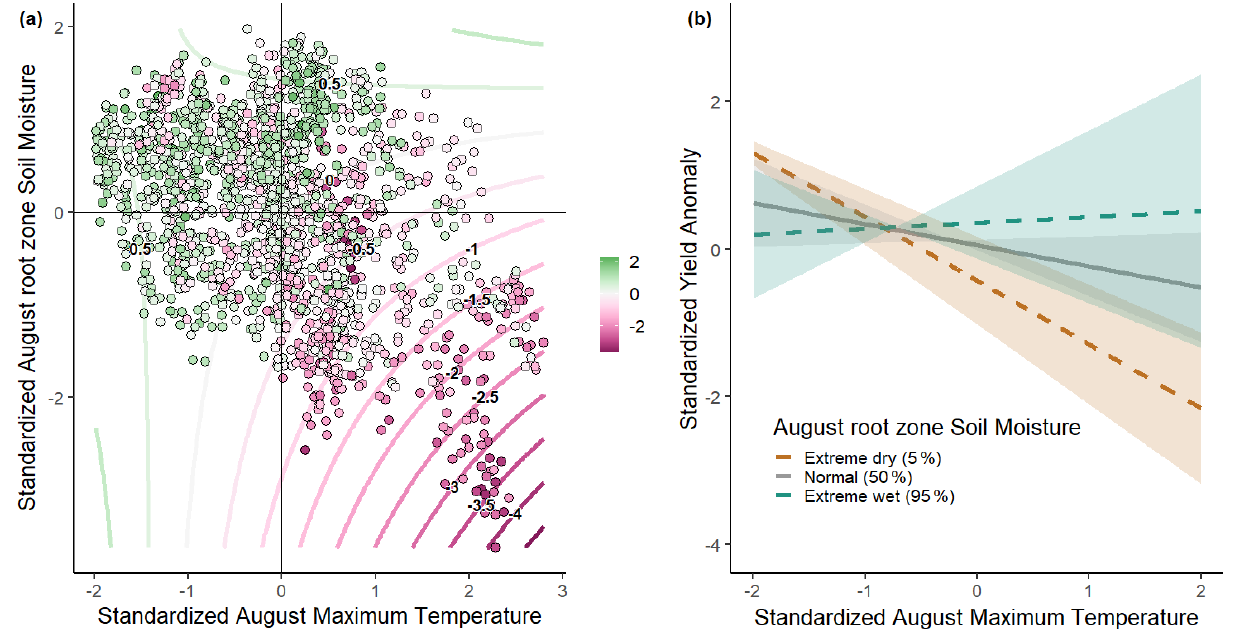
Figure 5. (a) Contour lines for modelled yield anomalies under varying levels of standardized August maximum temperature and root zone soil moisture in Illinois state. Points represent observed yield values. The colour scale to the right is in units of standardized yield anomaly. (b) The sensitivity of the Illinois US yield anomaly to temperature change for three different root zone soil moisture percentiles (5th, 50th and